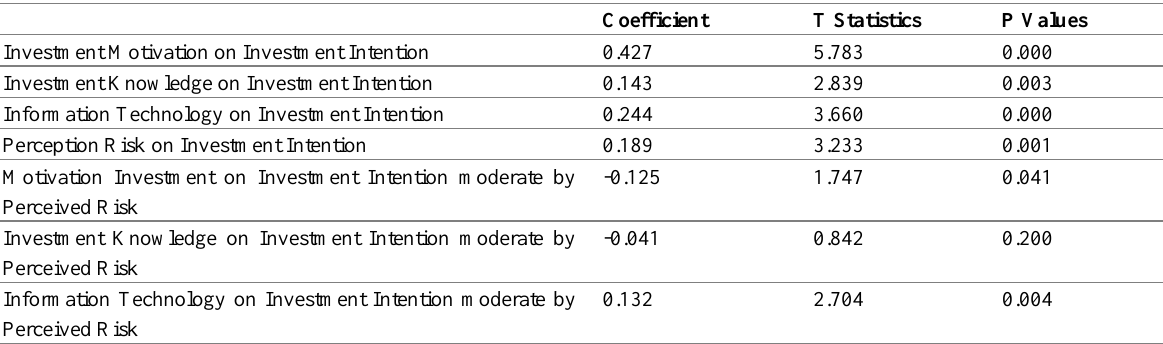
Table 2: Summary of